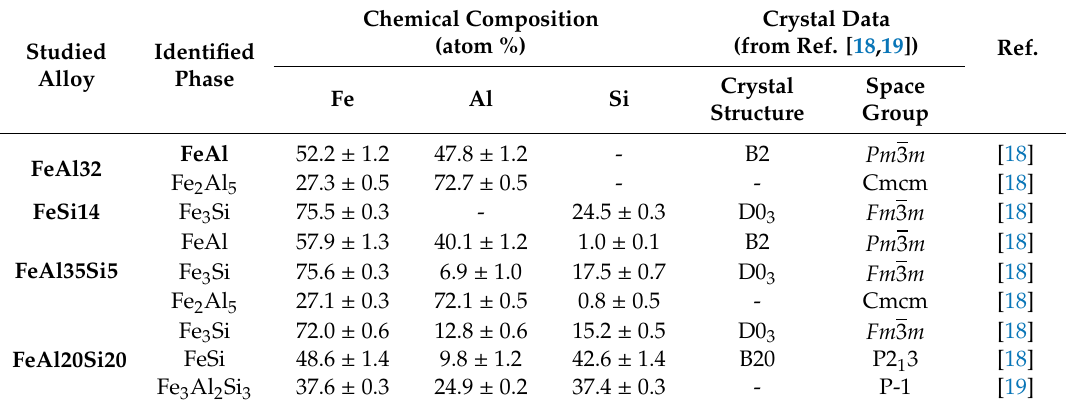
Figure 1. Optical micrographs of the tested materials: ( a ) FeAl32, ( b ) FeSi14, ( c ) FeAl35Si5, ( d ) FeAl20Si20. Table 2. Average chemical composition (analyzed by SEM–EDS) and crystal structures of the phases identified in tested alloys.